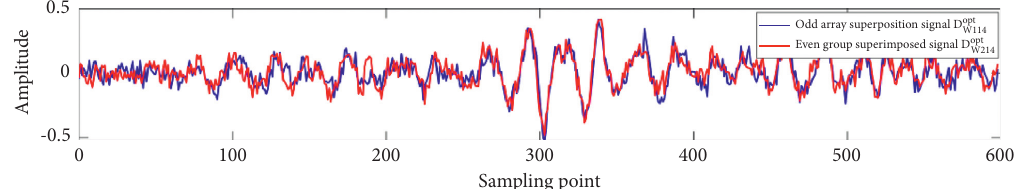
Figure 11: Odd and even groups superposition signals after 14-time superposition.